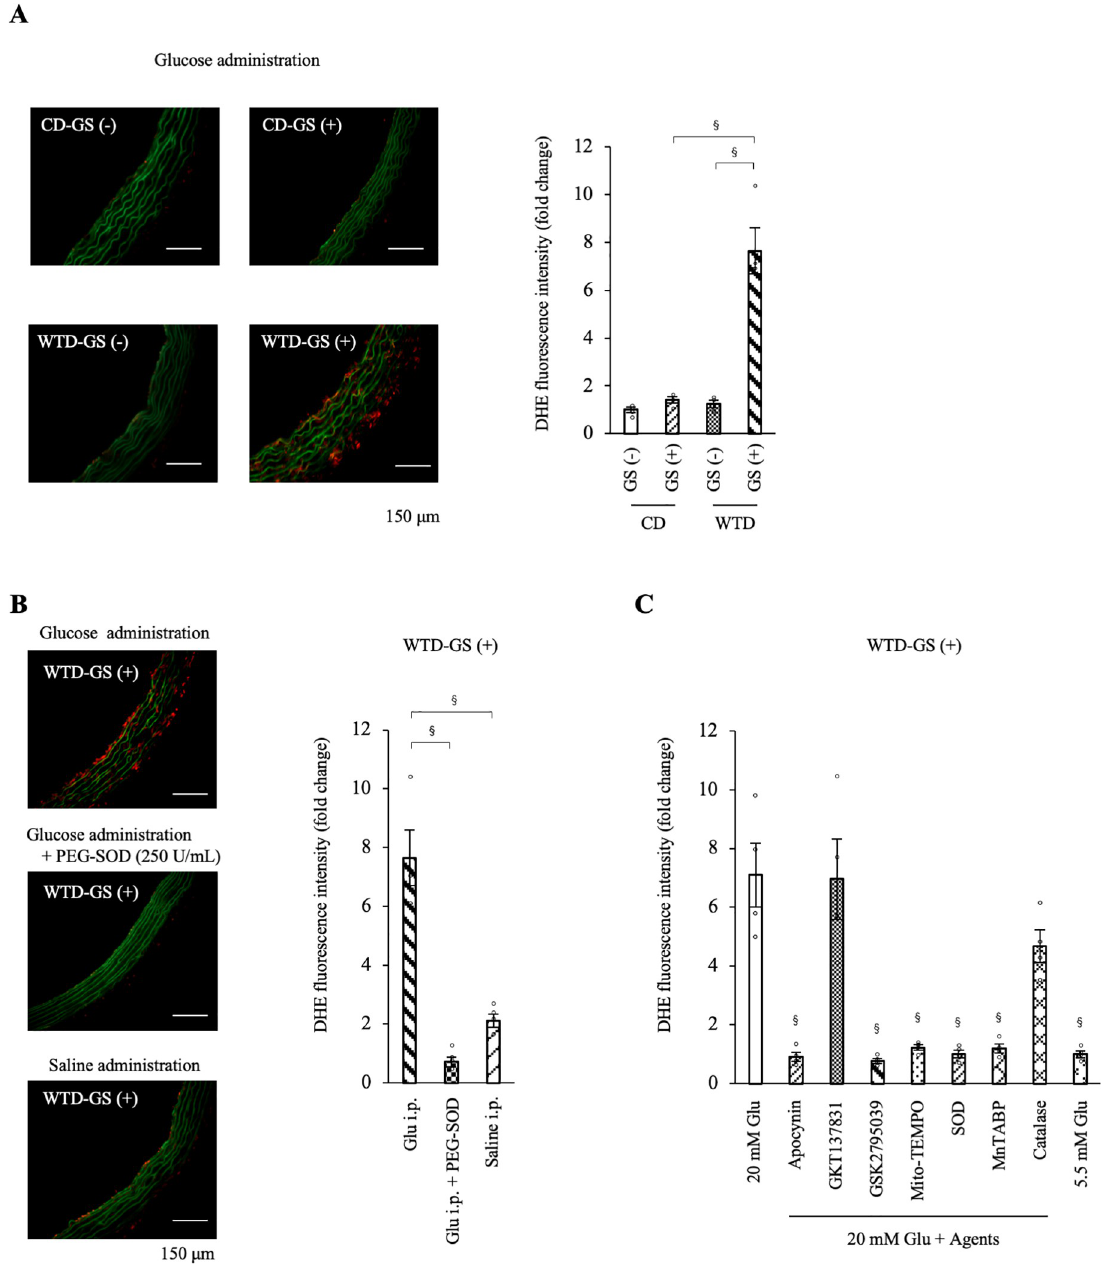
Fig 6. ROS production is increased by glucose spikes only in the WTD-GS (+) group and diminished by NOX2 inhibitor and a mitochondria-targeted superoxide scavenger. A: Representative images of DHE staining and the DHE fluorescence intensity in the thoracic aorta removed 2 hours after the intraperitoneal administration of glucose (1 g/kg). The significant interactive effect of diet and GS on DHE fluorescence intensity was confirmed by two-way ANOVA followed by a simple-effects analysis (§ P < 0.001). B: DHE fluorescence intensity in the aortas incubated with PEG-SOD and in the aortas removed after the intraperitoneal administration of saline to the WTD-GS (+) group. The control group (Glu i.p.) in the graph was the same as the WTD-GS (+) group in Fig 4A. § P < 0.001, one- way ANOVA. C: DHE fluorescence intensity in the aortas removed from the WTD-GS (+) group after equilibration in 20 mM glucose for 2 hours and with several pharmacological agents for 30 minutes. The 5.5 mM Glu group was composed of aortas removed from the WTD-GS (+) group after equilibration in 5.5 mM glucose for 2 hours without any pharmacological agents. § P < 0.001 compared with the 20 mM Glu group, Dunnett’s test. The DHE fluorescence intensity is presented as fold changes in fluorescence intensity relative to that of the 5.5 mM Glu group. The data are presented as the means ± SEM. N = 4 rats per group. Glu, glucose; i.p., intraperitoneal; PEG-SOD, polyethylene glycol-superoxide dismutase; apocynin, an NADPH oxidase (NOX) inhibitor; GKT137831, a NOX1 and 4 inhibitor; GSK2795039, a NOX2 inhibitor; Mito-TEMPO, a mitochondria-targeted superoxide scavenger; SOD, superoxide dismutase; MnTABP, a superoxide dismutase mimetic and peroxynitrite selective scavenger; CD, control diet; WTD, Western-type diet; GS, glucose spike.